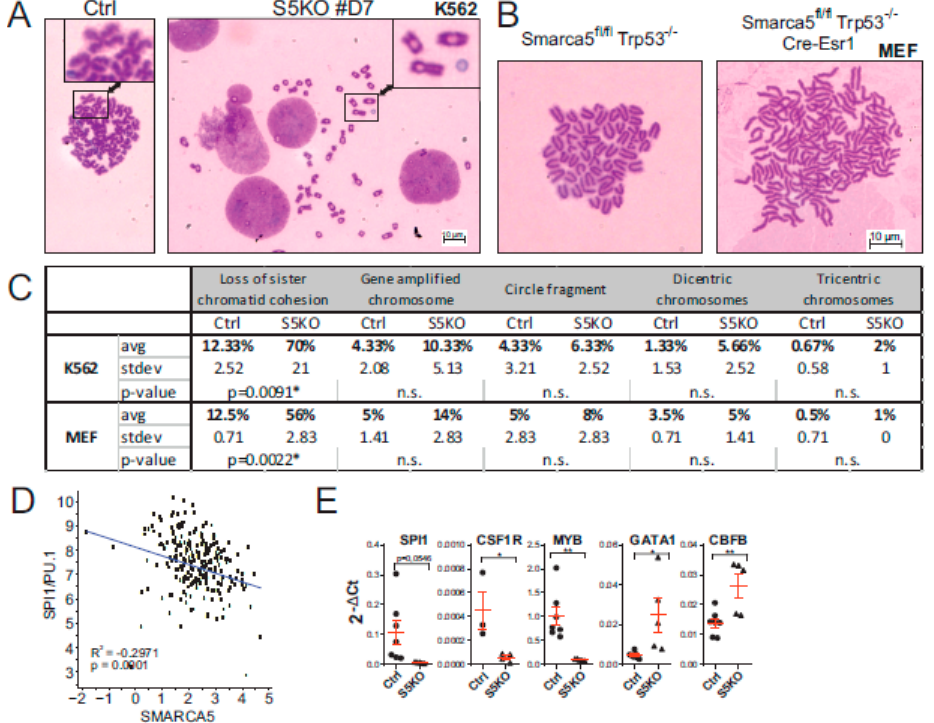
Figure 5. SMARCA5 loss causes karyotypic changes in K562 cells. ( A , B ) Mitotic chromosome analysis of S5KO cells vs control K562 cells (clone #D7, ( A )) or MEF cells ( B ). 1000X magnification. ( C ) Table summarizes all chromosomal aberrations; data from technical triplicates, for each replicate a total of 100 mitotic nuclei were counted. Mean percentage of chromosomal abnormalities with Stdev, Student’s t -test, p < 0.05 *. ( D ) Computational analysis of correlations between expression of SPI1 / PU.1 and SMARCA5 in samples of adult AML patient samples; for details, see Materials and Methods section. ( E ) Quantitative PCR analysis of SPI1, CSF1R, MYB, GATA1, and CBFB mRNAs expression in the S5KO clones ( n = 5) compared to controls ( n = 7). Data were normalized to the GAPDH mRNA. Student’s t -test, p < 0.05 *, p < 0.001